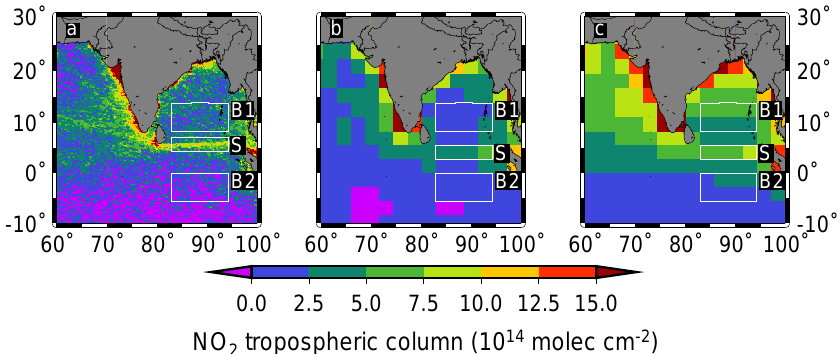
Fig. 2. February mean tropospheric NO 2 columns: (a) derived from SCIAMACHY measurements from 2003 to 2008 using the DOAS technique and the tropospheric excess method (TEM). (b) taken from the E5/M1 model using the TEM. (c) taken from the E5/M1 model integrating the NO 2 concentration up to approximately 200hPa (SUM). The white boxes indicate the averaging regions used for further comparison.